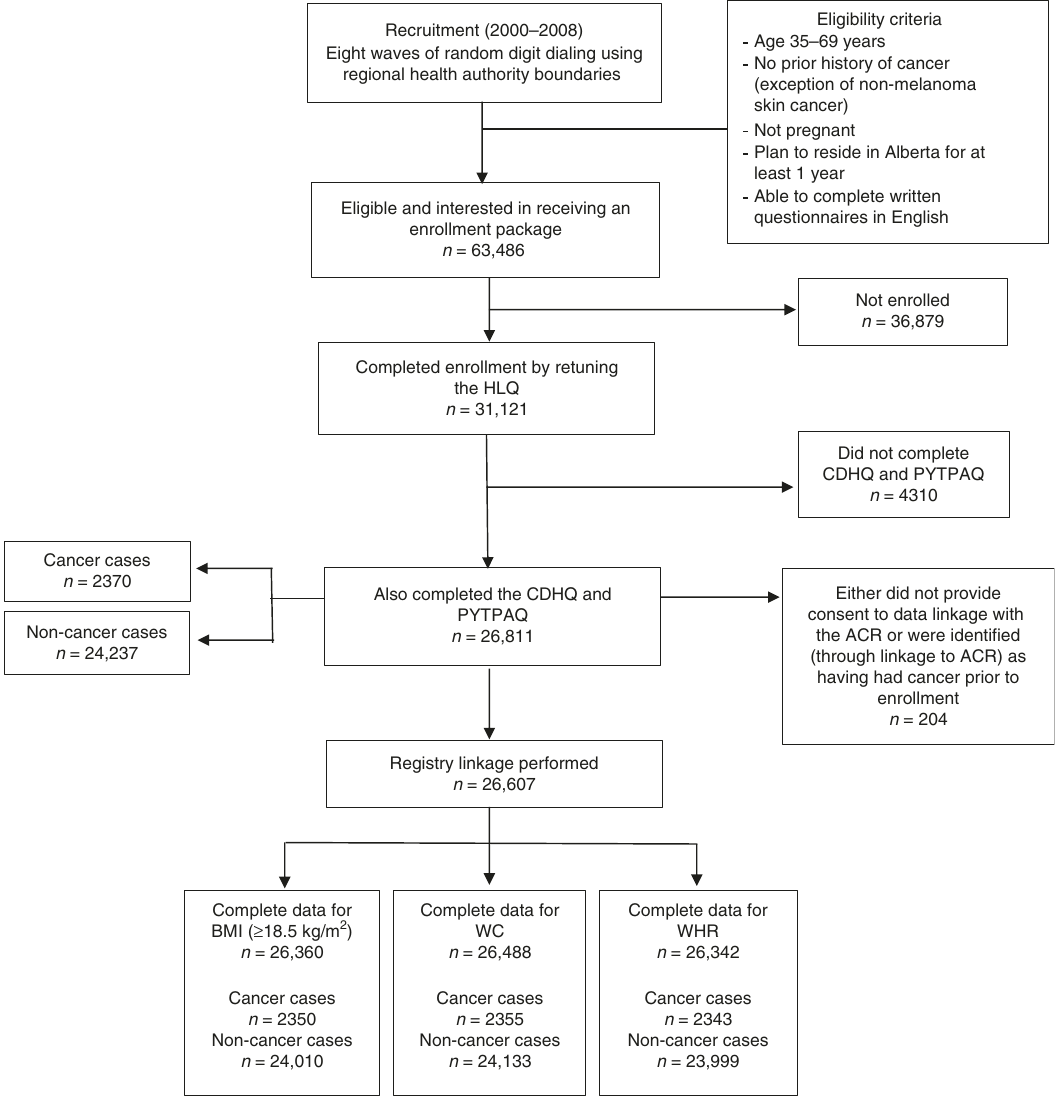
Fig. 3 Recruitment, enrollment, and analytic sample selection fl ow diagram for Alberta ’ s Tomorrow Project, resulting in an analytic sample of 26,607